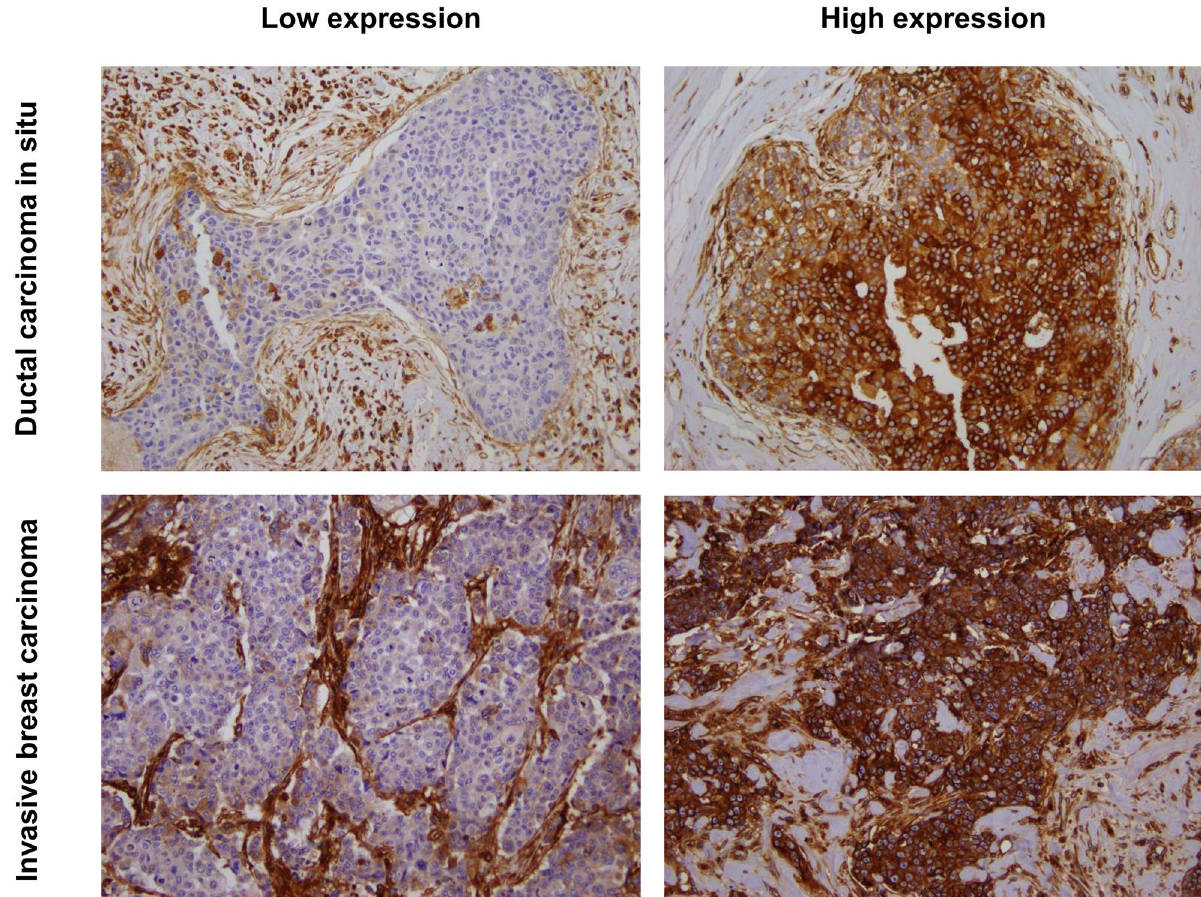
Figure 1. Representative images of immunostaining with human leukocyte antigen (HLA) class I in ductal carcinoma in situ (DCIS) and invasive breast carcinoma (IBC). In the low level expression group, tumor cells exhibit a complete loss of membranous expression or weak, focal membranous expression of HLA class I compared to the stromal cells that show strong expression. Conversely, tumor cells in the high level expression group show mostly diffuse and strong, complete membranous expression in both DCIS and IBC.